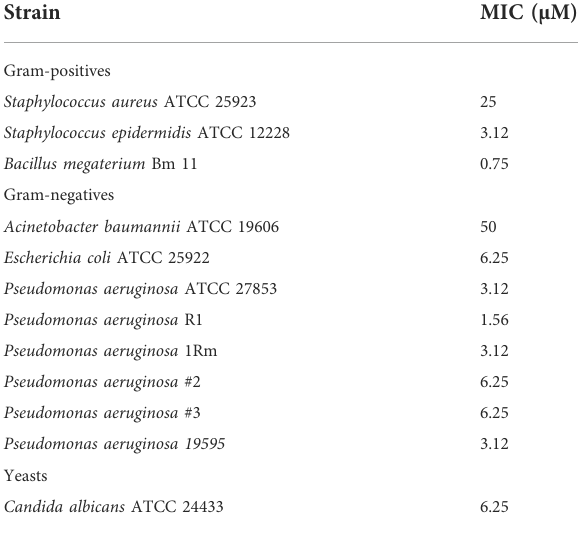
TABLE 2 Antimicrobial activity of KDEON peptide, expressed as MIC values.